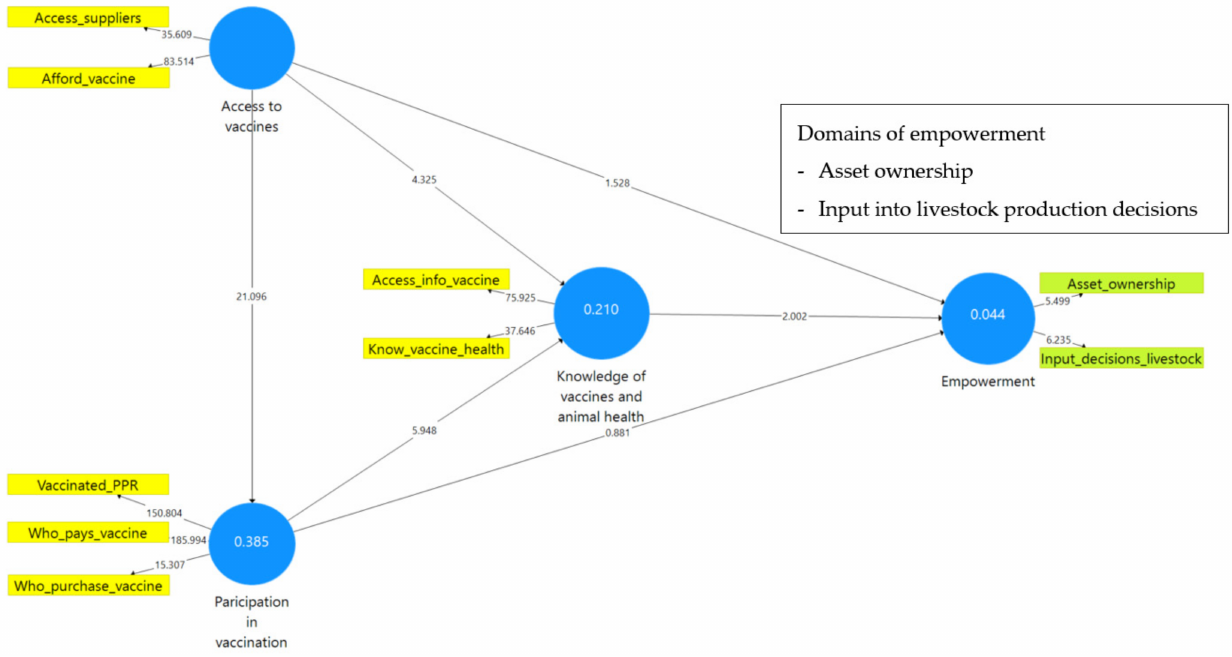
Figure 3. PLS-SEM model results from women respondents.